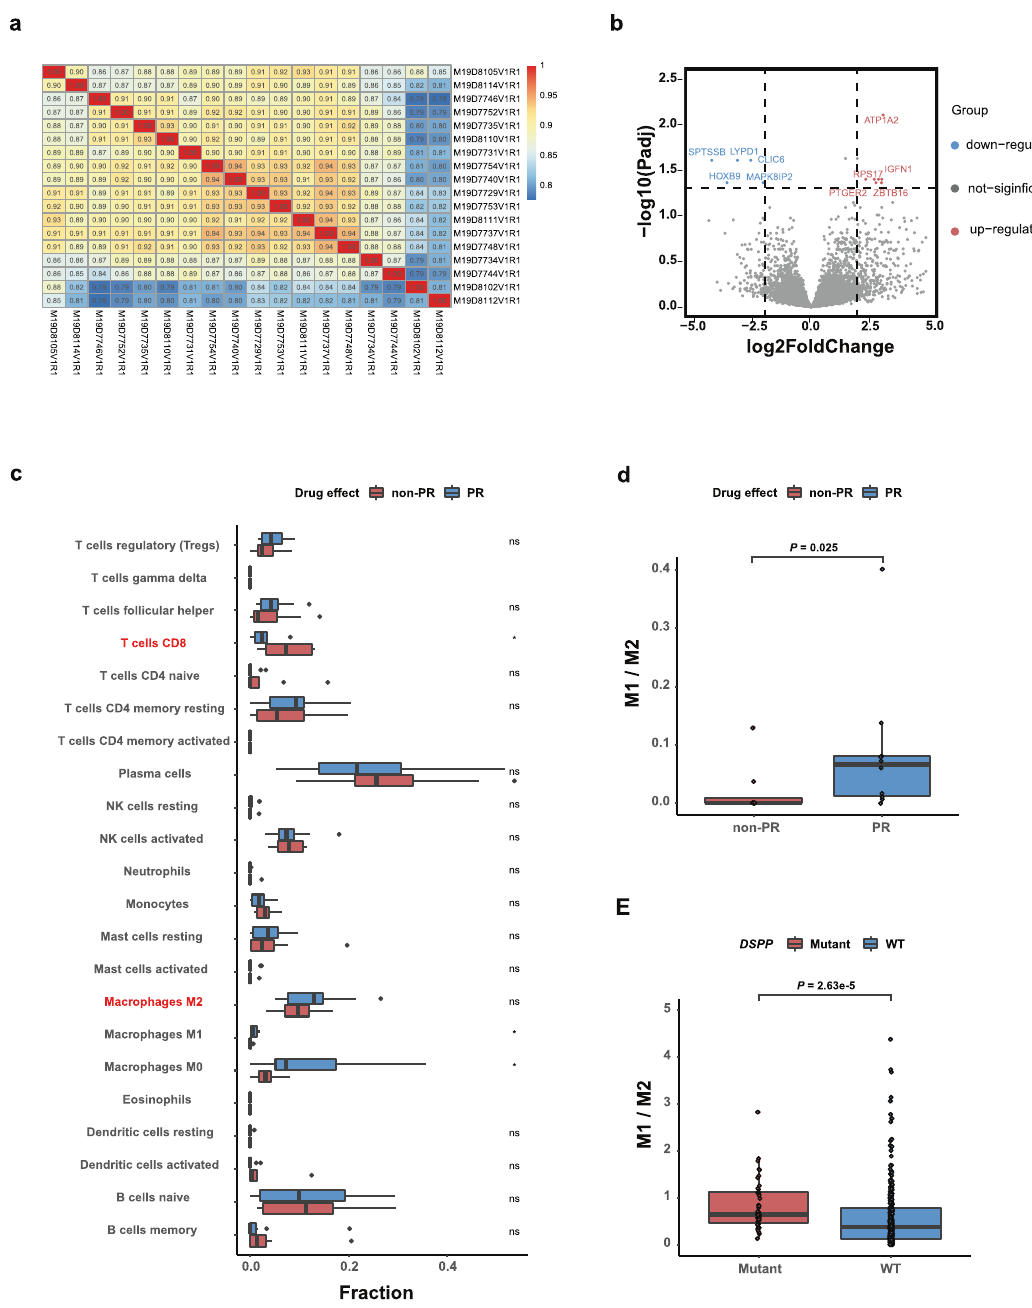
Fig. 4 Integrated analysis of whole exome and transcriptome sequencing. a Sample correlation heat map based on expression matrix; different colors represent different correlation coef fi cients. b Volcano plot of eight upregulated and fi ve downregulated differentially expressed genes between PR and non-PR group, each of them labeled the names of the fi rst fi ve genes. c Immune analysis of PR versus non- PR group from our cohort (Wilcoxon signed-rank test). d M1/M2 macrophage ratio of PR versus non-PR from our cohort (Wilcoxon signed-rank test). e M1/M2 macrophage ratio of DSPP -mutant versus wild-type tumors from EGFR- mutant samples obtained from TCGA (Wilcoxon signed- rank test). * P < 0.05, ** P < 0.01, ** *P < 0.001, **** P <